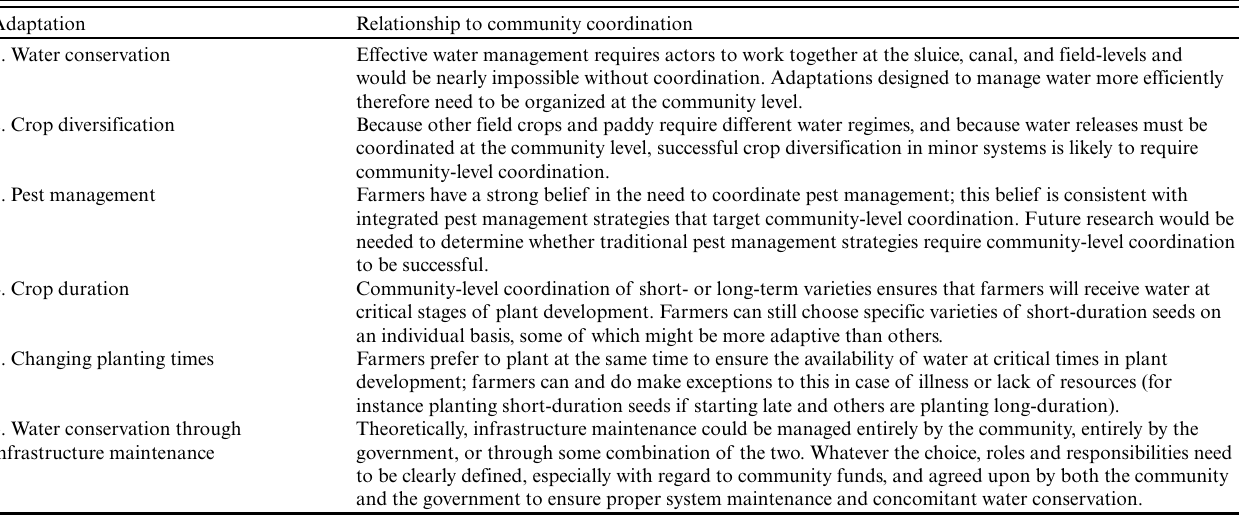
Table 3 . Summary of the relationship between adaptations and community